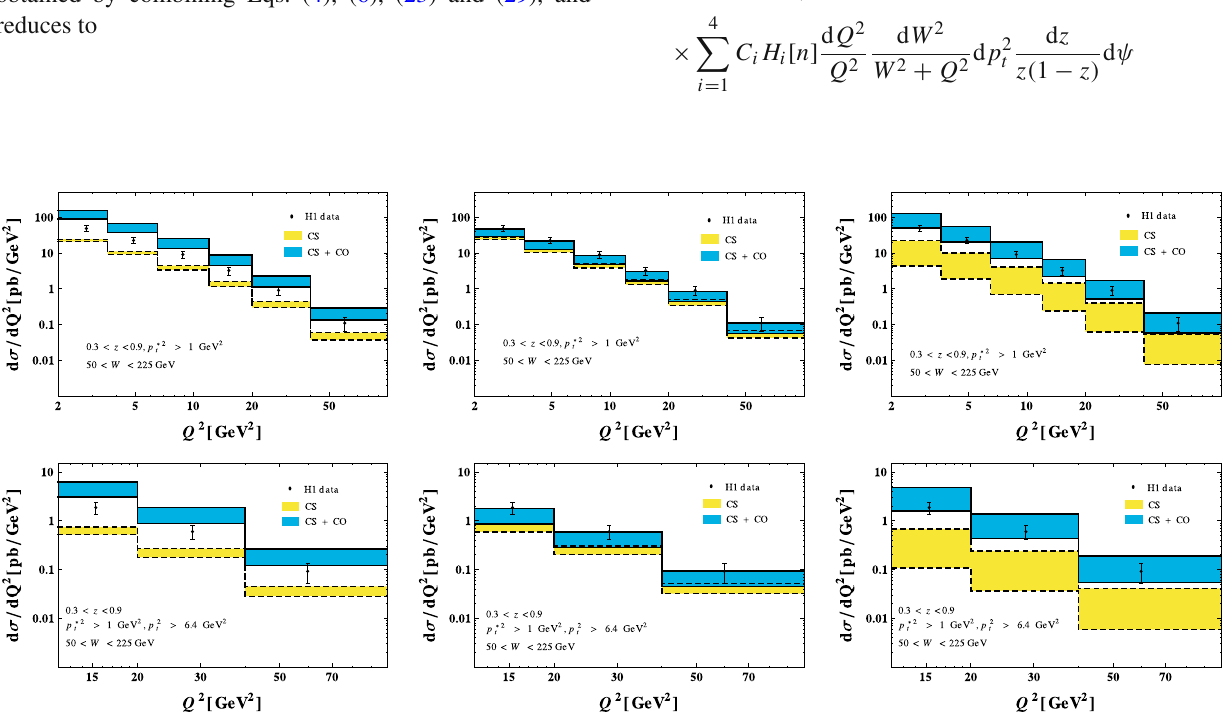
Fig. 6 The differential cross sections for the J /ψ production in DIS with respect to Q 2 . The experimental data are taken from Ref. [49]. The l.h.s., middle, and r.h.s. plots correspond to the LDMEs taken in Refs. [28,30,41], respectively